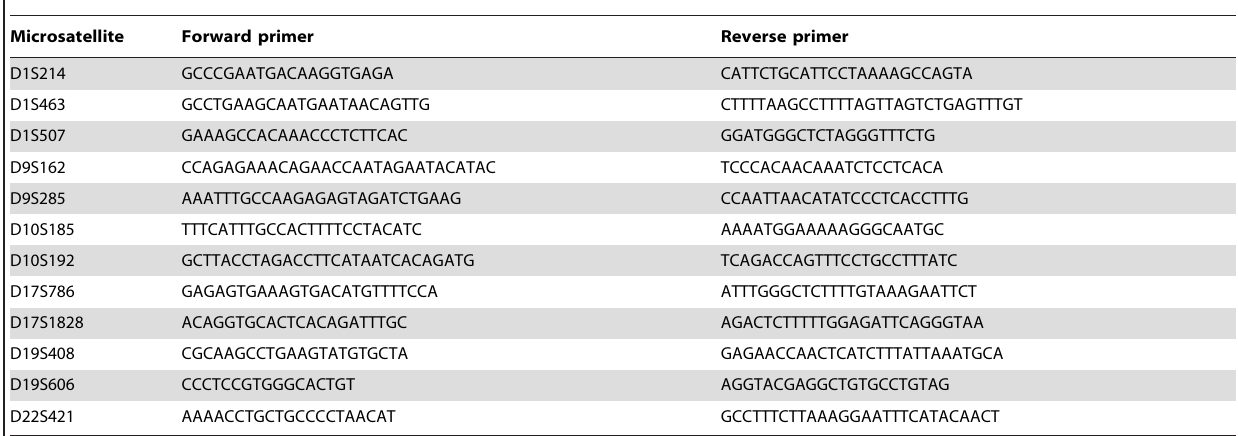
Table 1. Summary of primer sequences used for real-time PCR.